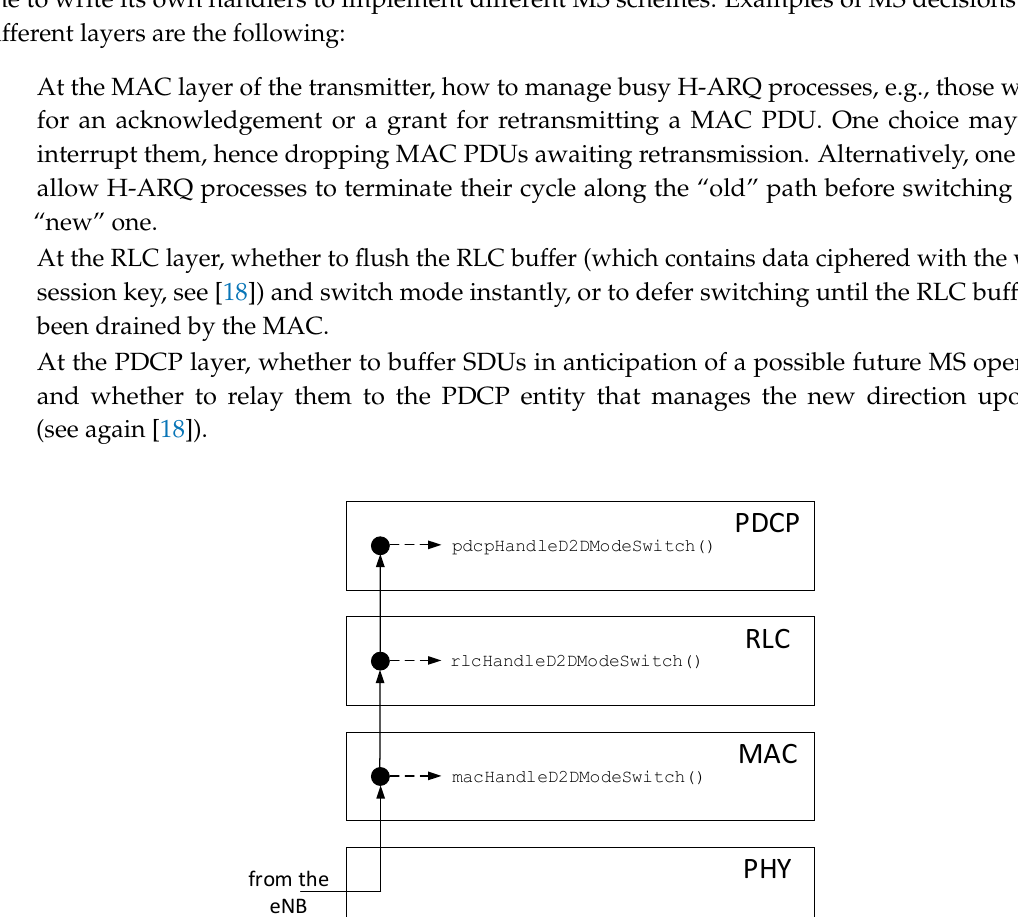
UE1 UE3 Figure 13. Allocation map with frequency reuse. Our support for D2D-aware resource allocation algorithms in SimuLTE allows one to enforce frequency reuse among D2D connections (both P2P and P2MP), but prevents two UL connections in the same cell to share resources. To keep track of reuse, we make available a data structure that computes potential conflicting transmissions based on a topological approach. In the latter, we